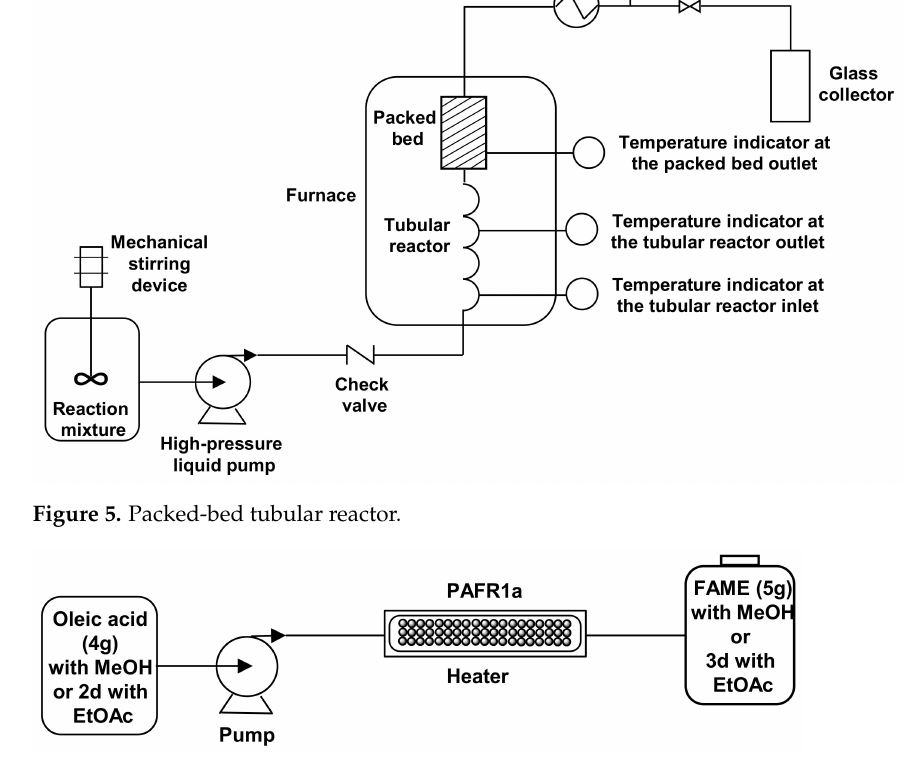
Figure 6. PAFR-packed flow